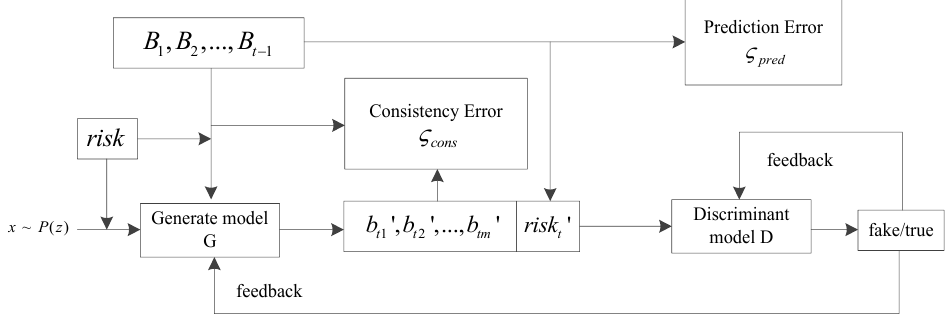
Figure 4. GAN model structure.